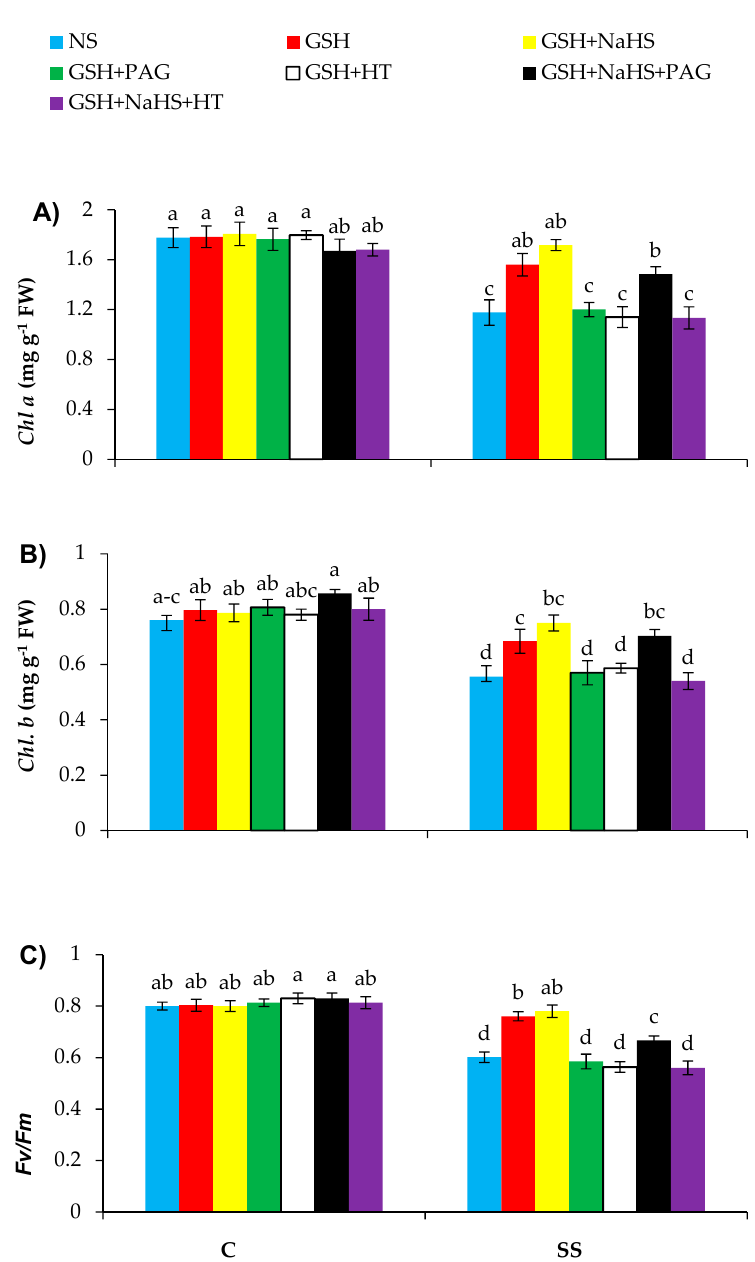
Figure 3. Chlorophyll a ( A ) and chlorophyll b ( B ) on a fresh weight (FW) basis and chlorophyll fluorescence parameters ( F v / F m ( C )) in pepper plants grown under control (C) and salinity stress (SS 100 mmol L − 1 NaCl), sprayed with glutathione (1.0 mmol L − 1 GSH) or sodium hydrosulfide (0.2 mmol L − 1 NaHS) alone or together, combined with a 0.1 mmol L − 1 scavenger of H 2 S,